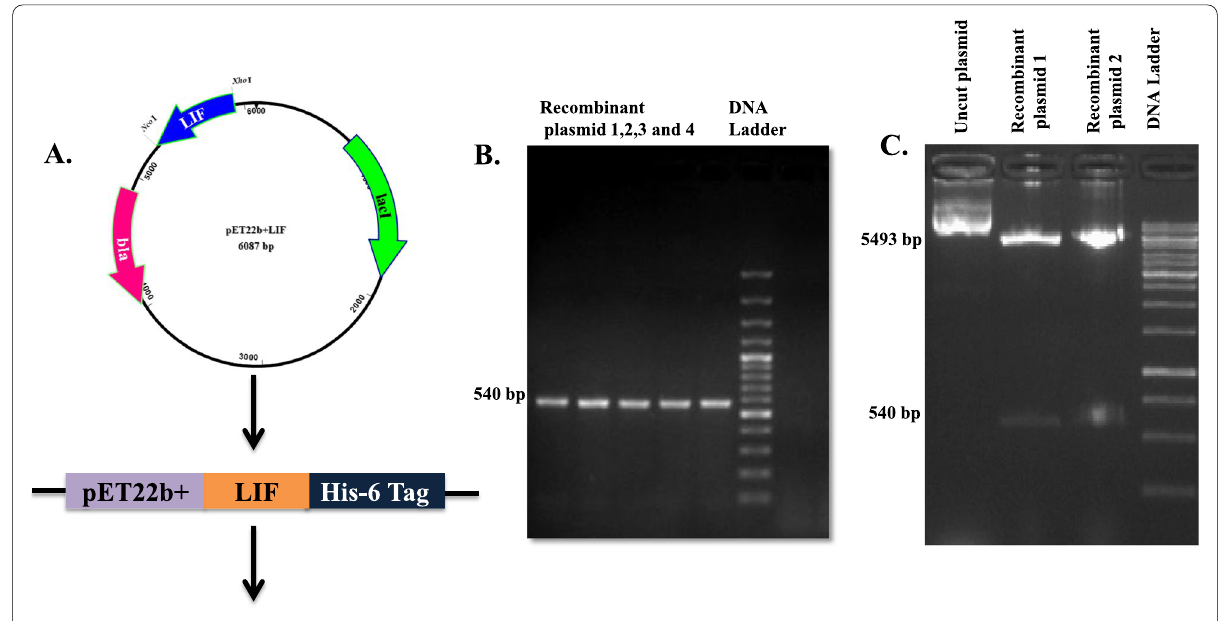
Fig. 1 Construction of expression vector containing BuLIF. A . Vector map of pET22b( ) pelB/BuLIF constructed via Lasergene software. BuLIF + encoding 540 bp without signal sequence was in cooperated into pET22b( ) vector and named as pET22b( ) pelB/BuLIF. The constructed + + expression vector encodes an N-terminal hexahistidine (His6) fused to the BuLIF (His6-BuLIF). This construct was transformed into Top 10F ′ competent E. coli cells. B The presence of BuLIF gene was confirmed by colony PCR and double restriction enzymes digestion analysis using NCo Ι and Xho Ι . Bands of 540 bp from different recombinant plasmids were observed in agarose gel. C Upon restriction digestion, two products of 540 bp BuLIF and 5493 bp pET22b( ) vector were released from recombinant plasmid confirming the presence of BuLIF in the expression vector. + Uncut plasmid was run alongside the digested recombinant